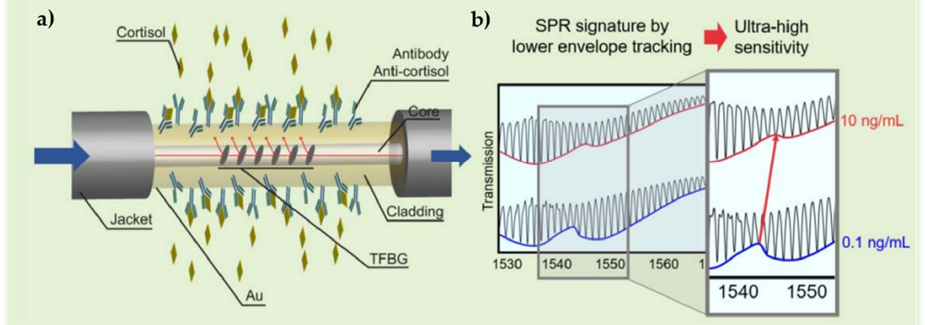
Figure 15. SPR-based TFBG developed for specific detection of cortisol as a stress biomarker: ( a ) Au thin film on the TFBG was modified with cysteamine and then anti-cortisol antibodies were covalently bonded via EDC/NHS chemistry; ( b ) representation of the SPR signature spectra variation and the corresponding lower envelope as a response to two different cortisol concentrations. Reprinted with permission from ref. [92]. Copyright 2021 IEEE, Piscataway, NJ, USA.